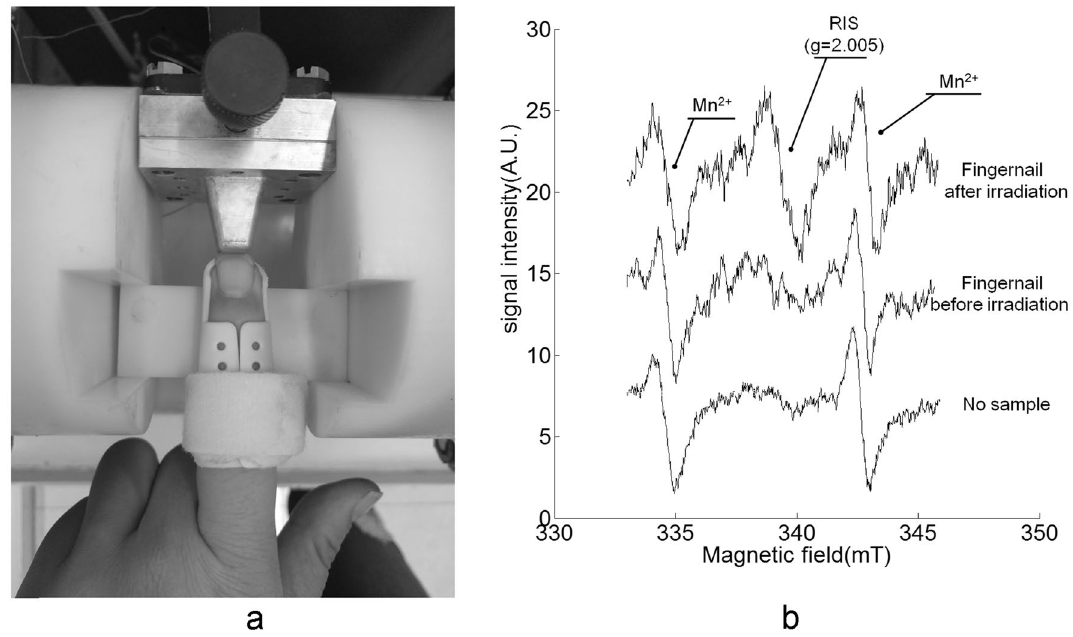
Figure 5. The in vivo EPR spectroscopy of fingernail. ( a ) The fingernail was inserted into the detection aperture in the state of being measured. ( b ) The EPR spectra of the in vivo measurement of the fingernails before irradiation and after irradiation by 6